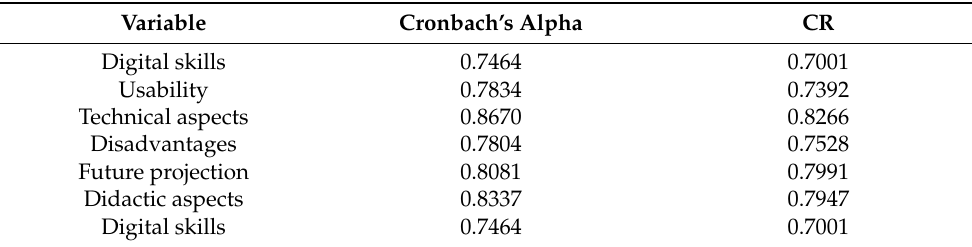
Table 1. Composite reliability (CR) and Cronbach’s alpha